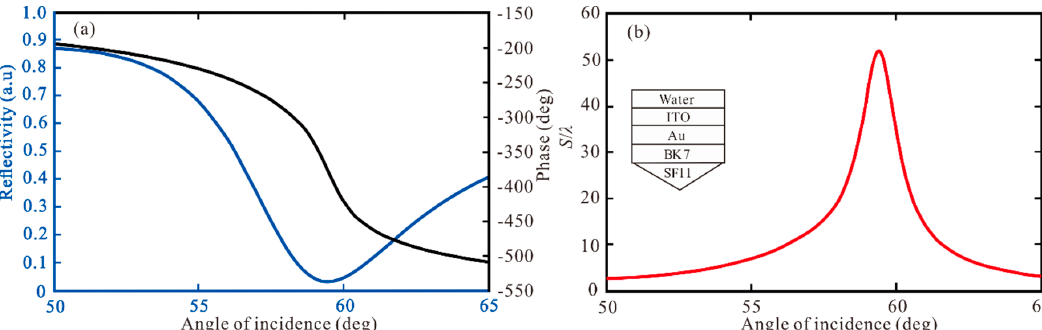
Figure 2. The change of ( a ) reflectivity and phase respect to angle of incidence; ( b ) Goos-Hänchen (GH) shift with respect to angle of incidence for Au-ITO structure.